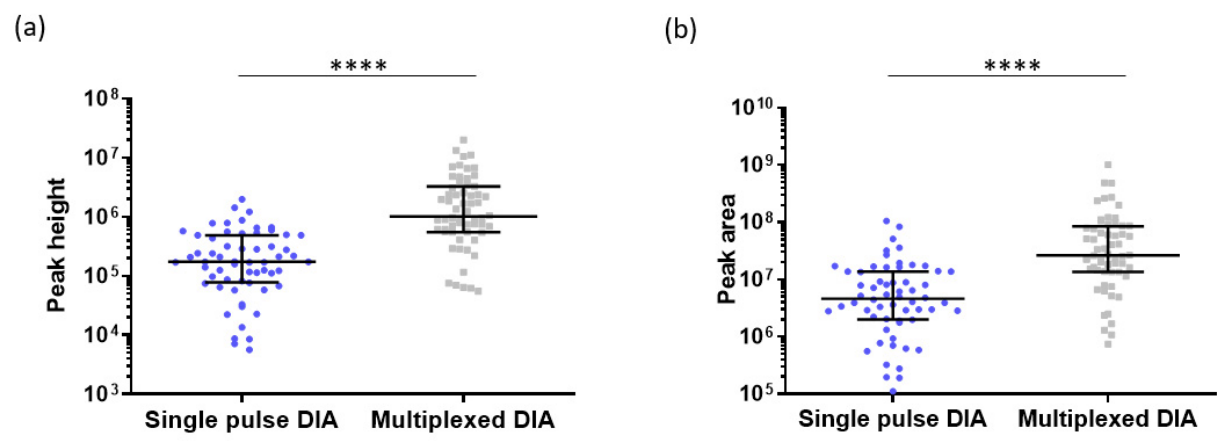
Figure 7. ( a ) Peak height of 60 representative peptides in single pulse DIA and in multiplexed DIA without CE; ( b ) Peak area of 60 representative peptides in single pulse DIA and in multiplexed DIA without CE. Analytical column: µPAC 50 cm; Sample: 500 ng HeLa Protein Digest Standard, Column temperature: 25 °C. Black lines represent the median with interquartile range. **** ( p -value < 0.0001) (Mann–Whitney test).